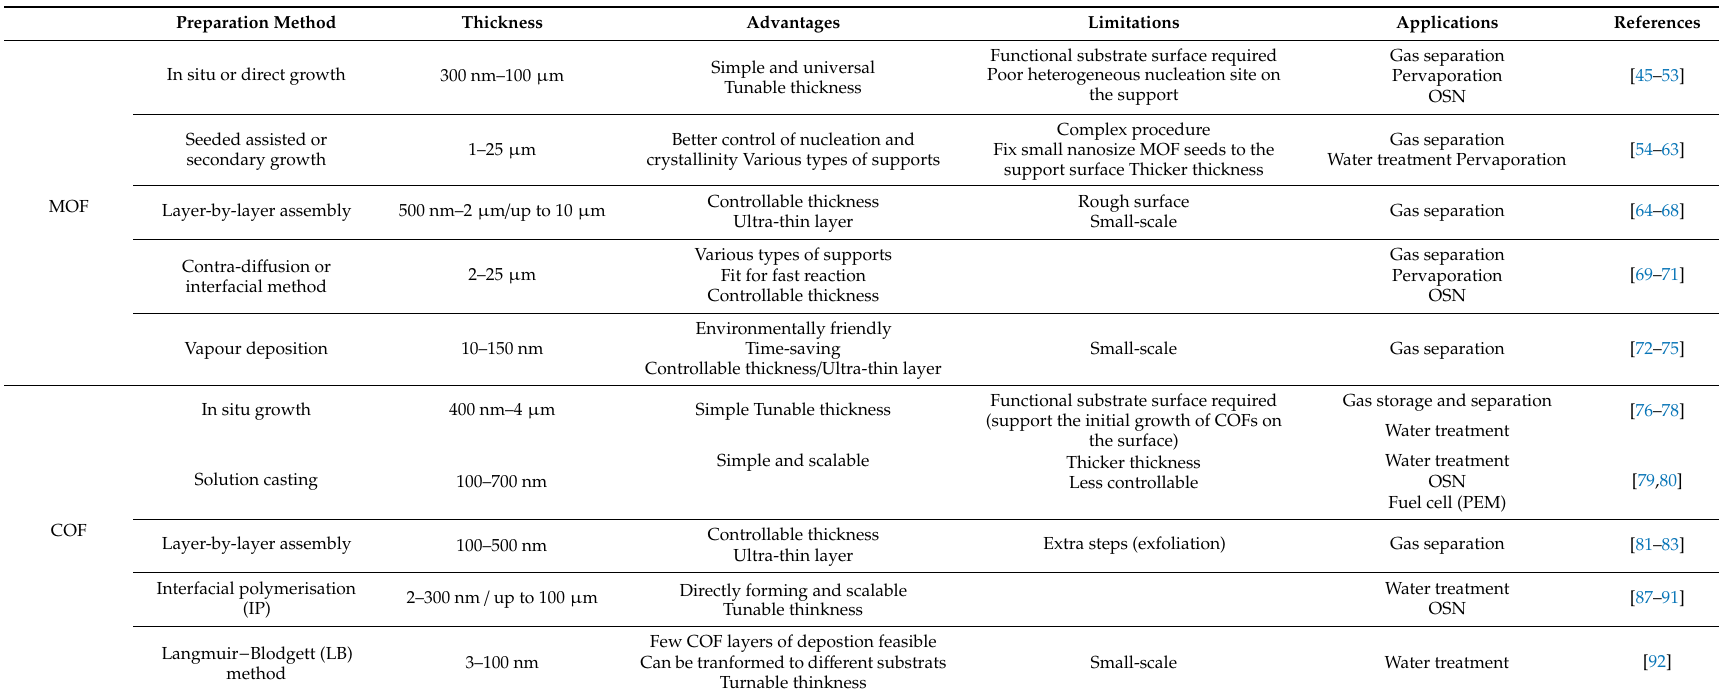
Table 1. Summary of MOF and COF membrane preparation